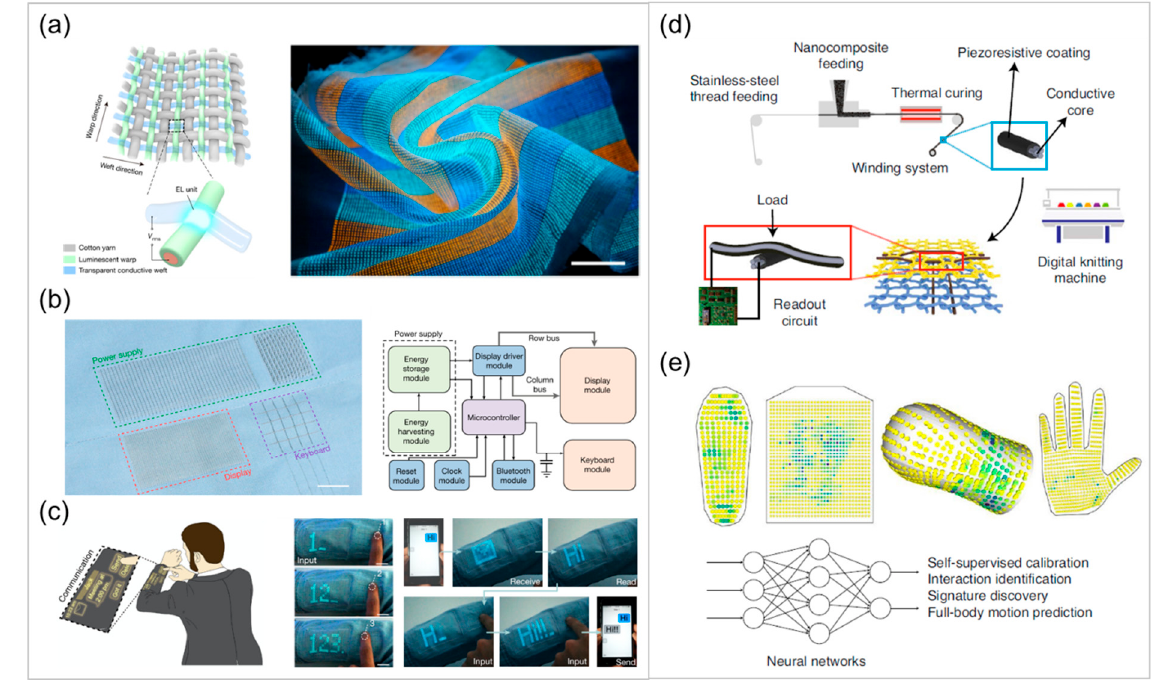
Figure 8. ( a ) Left: Schematic of the woven display textile. Each contacting luminescent warp and transparent